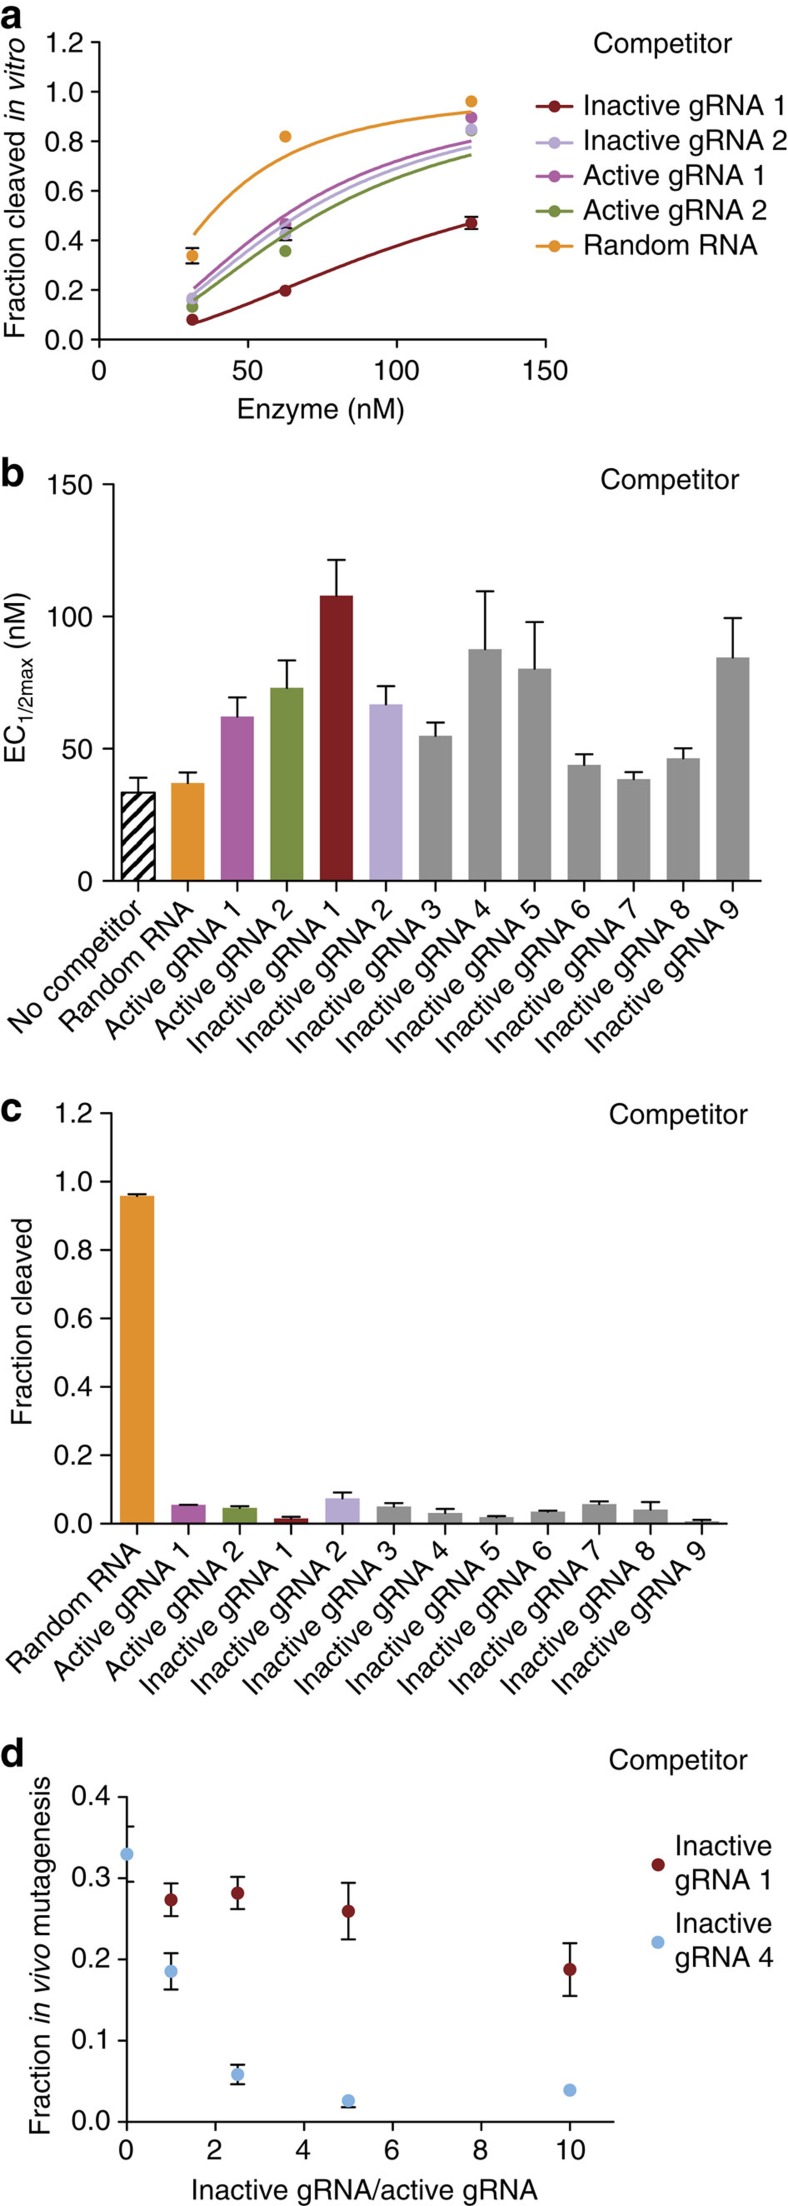
Inactive gRNAs bind to Cas9 protein.(a) Example target site cleavage traces for a highly active gRNA–Cas9 complex combined with an equivalent amount of competitor inactive gRNA (Supplementary Table 2), active gRNA (Supplementary Table 3) or control random RNA (Supplementary Methods). The inactive gRNAs elicit no cleavage at the enzyme concentrations tested. (b) EC1/2max values for a highly active gRNA–Cas9 complex without a competitor (black striped bars) or combined with an equivalent amount of nine inactive gRNAs, two active gRNAs or control random RNA. (c) After prior incubation of 125 μM Cas9 protein with nine inactive gRNAs, two active gRNAs or control random RNA for 15 min, the cleavage for an active gRNA at its target was measured. (d) In vivo cleavage activity for a highly active gRNA (active gRNA 3, Supplementary Table 3) with Cas9 mRNA combined with a varying amount of each of two inactive gRNAs. At least two independent assays were completed for each mutagenesis or in vitro cleavage experiment and error bars shown in all panels are s.e.m.